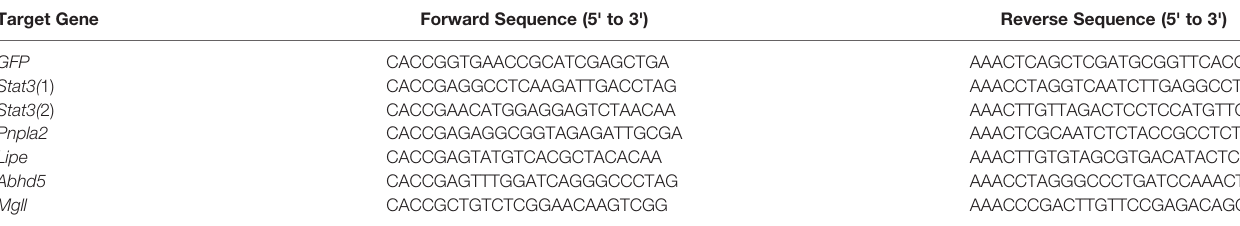
TABLE 2 | Oligonucleotide Sequences for sgRNA-lentiCRISPR/Cas9